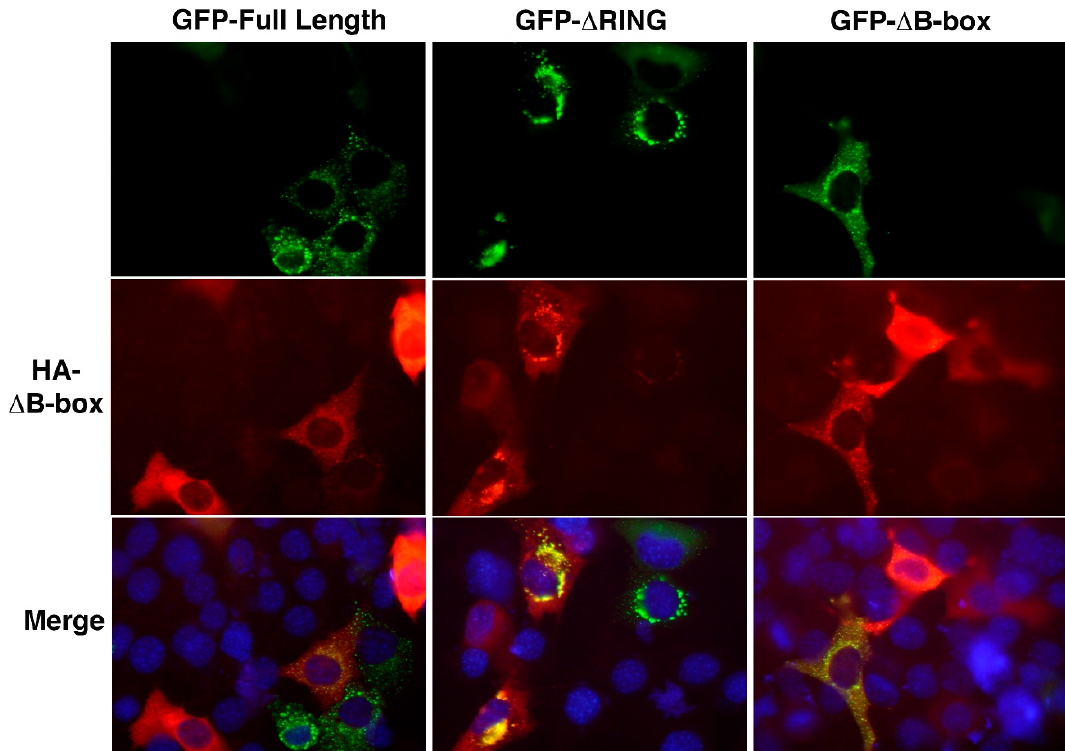
Figure 7. Co-localization of TRIM32 mutants. Representative images of C2C12 myoblasts co-expressing exogenous HA- Δ B-box (red signal) and GFP-tagged full-length TRIM32 or Δ RING, Δ B-box mutants (green signal). Localization was assessed by fluorescence imaging with nuclei counterstaining (DAPI) at 40× magnification.